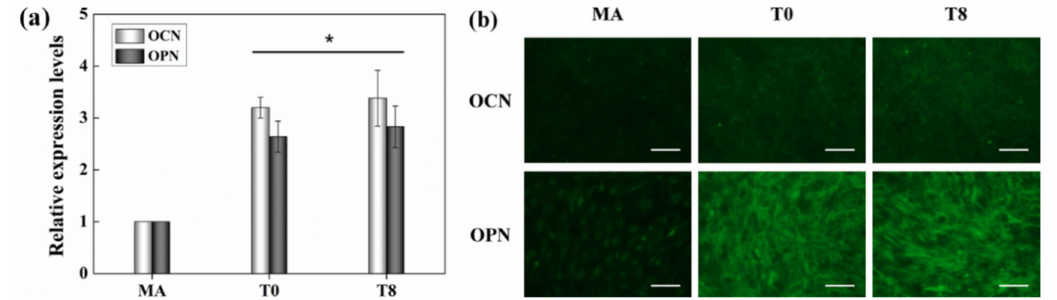
Figure 6. Osteogenic di ff erentiation of osteoblasts on the specimens for 21 d. ( a ) The expression levels of osteopontin (OPN) and osteocalcin (OCN) assessed by real-time RT-PCR (* p < 0.05 vs. MA). ( b ) Fluorescence images of OCN (upper) and OPN (lower) (scale bar = 100 µ m).